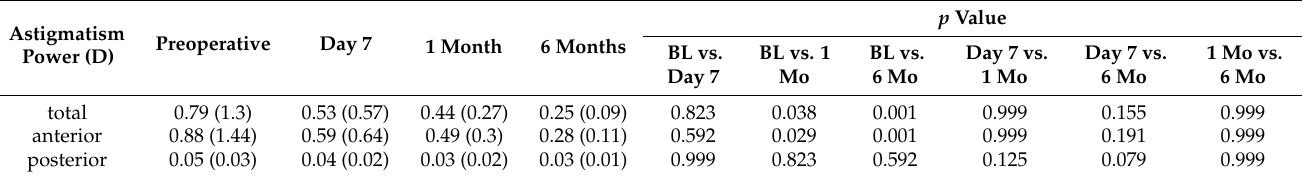
Table 5. Values of high order aberrations (D) in eyes with pterygium treated with autologous conjunctival transplantation with the use of human fibrin tissue